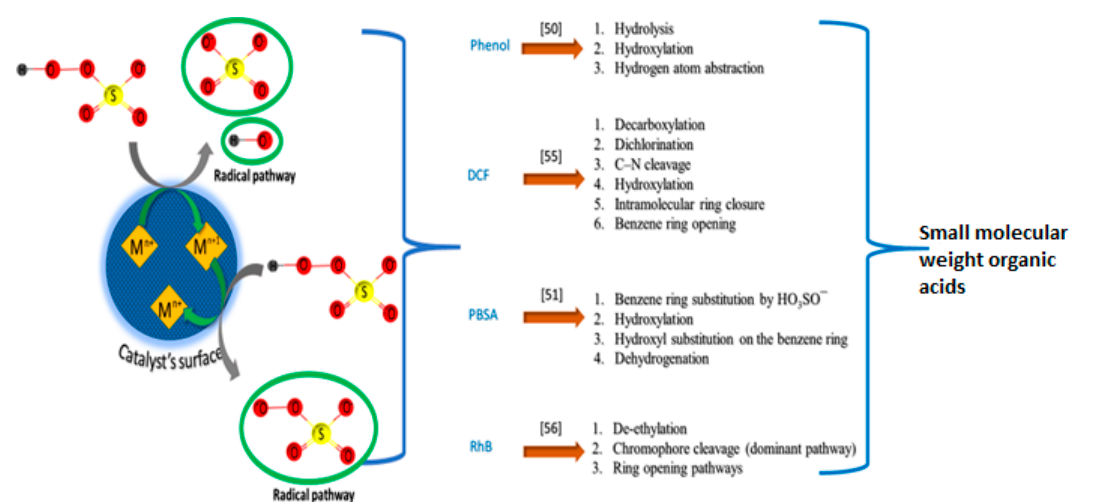
Figure 4. Schematic representation of simple perovskite catalyzed activation of PMS for the degradation of organic pollutants [53,54,58,59].